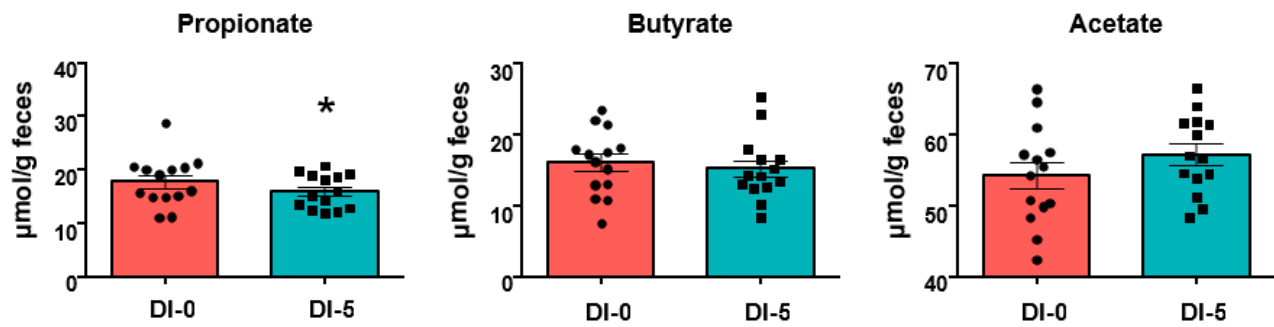
Figure 5. SCFA quantification in stool samples ( n = 14) collected before (DI-0) and after 5 days of dry immersion (DI-5). * p < 0.05 (paired Student-t test). Data are mean ± SEM .